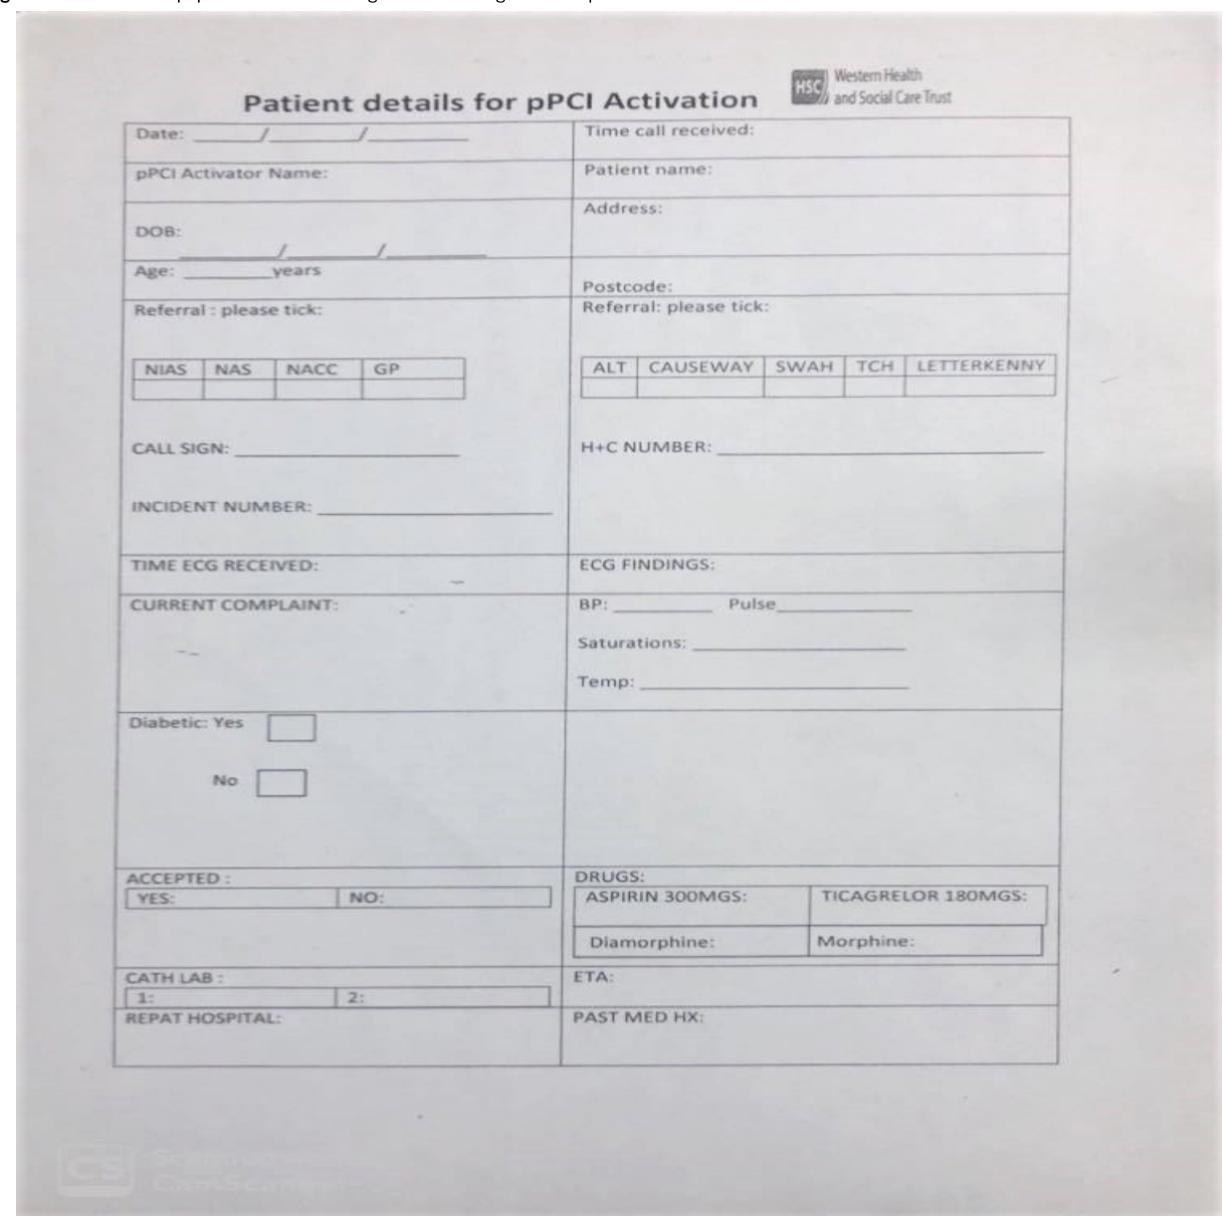
Figure 1. The current paper-based form being used at Altnagelvin